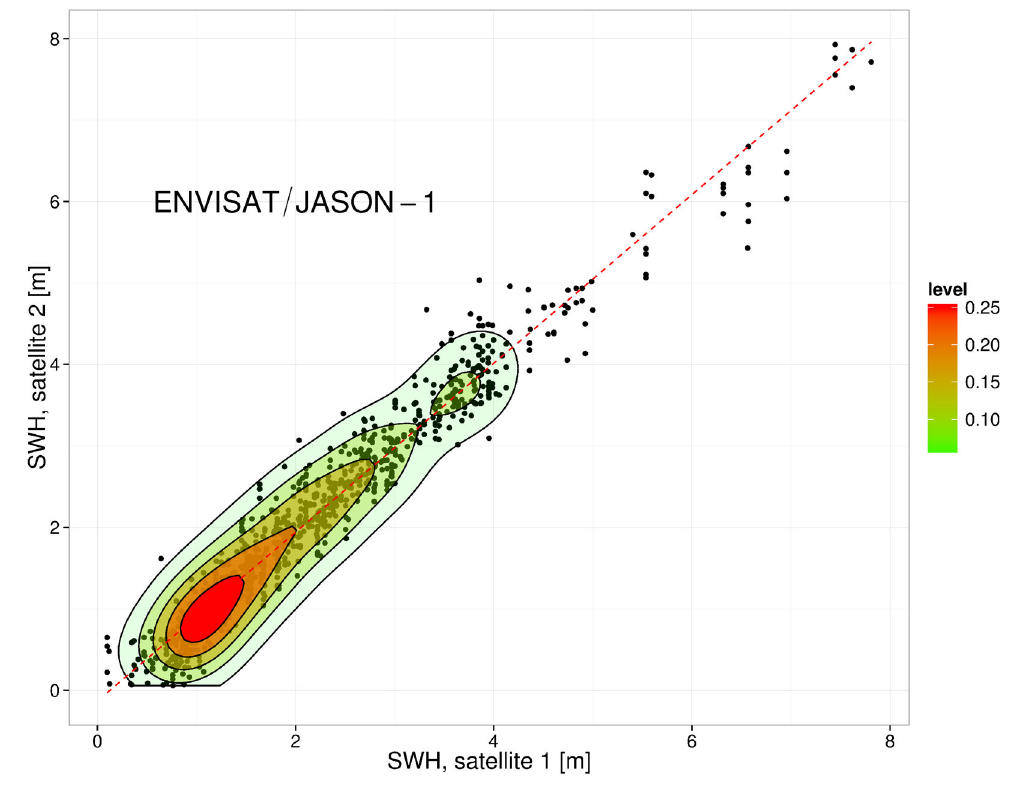
Fig. 8. Comparison of significant wave heights from JASON-1 and ENVISAT.